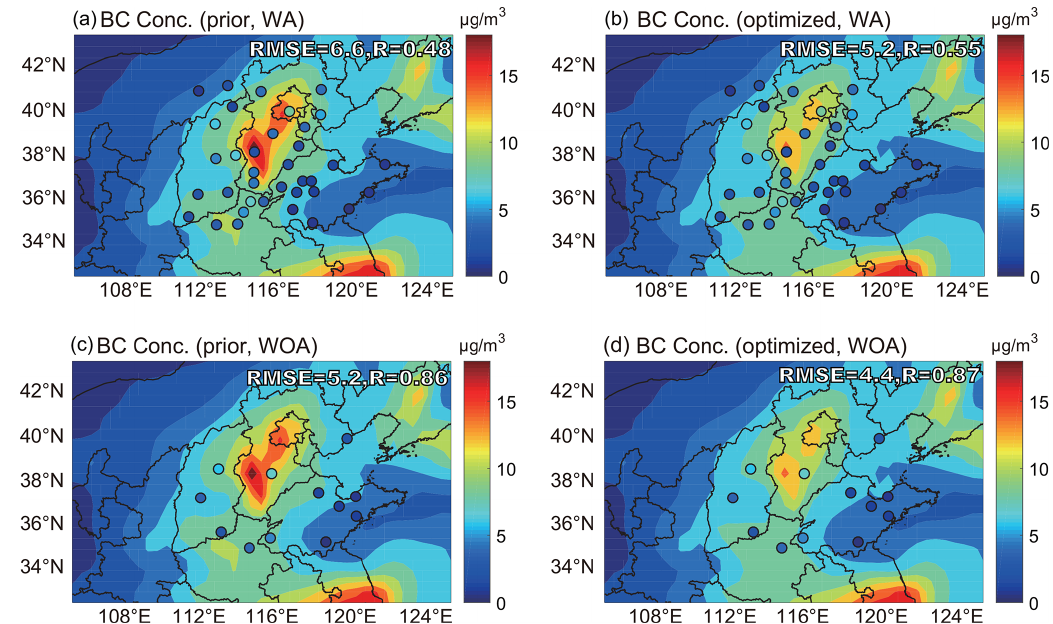
Figure 4. The spatial distribution of observed and simulated daily BC concentrations on 4 July 2016. The observations (circles) are over- plotted over model simulations with the (a, c) prior and (b, d) optimized emissions. The observations at 36 cities in (a) and (b) were used in the assimilation, and the observations at 12 cities in (c) and (d) were not used in the assimilation. The root-mean-square error (RMSE) and correlation coefficient ( R ) between observation and simulation are shown as insets. The observed BC concentrations were calculated by the BC / PM 2 . 5 ratio